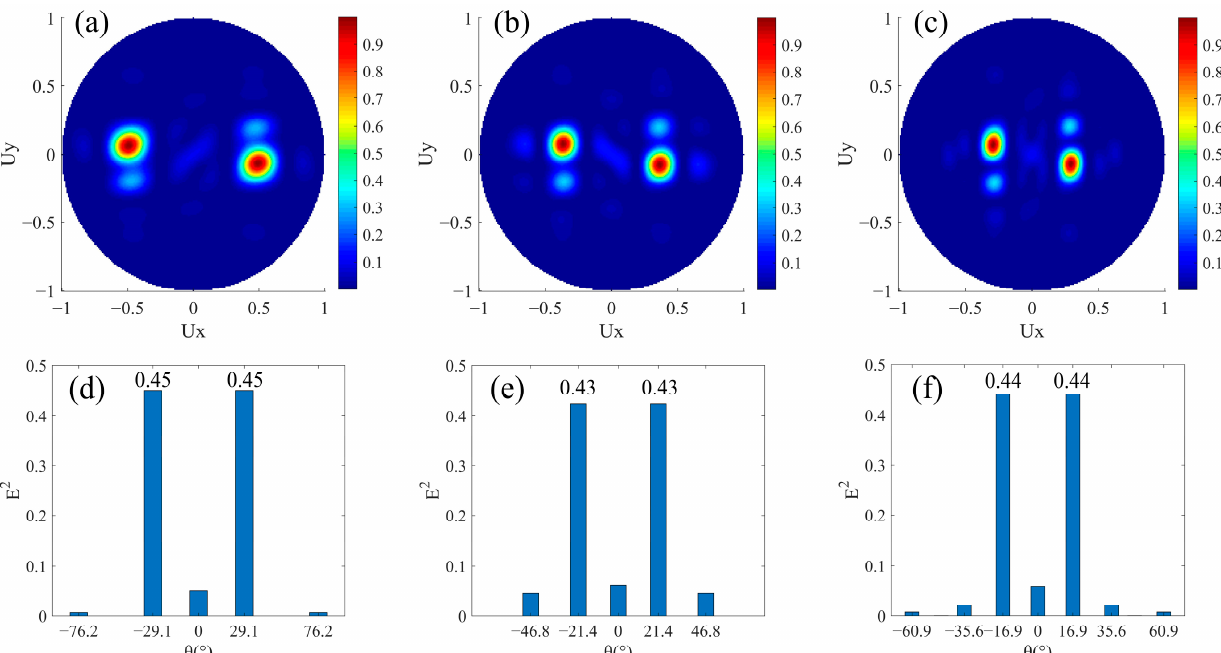
Figure 2. Simulation results of beam splitters with same split angle and energy. N l = N r , M = 0. The normalized far-field projection intensity distributions of designs ( a ) N l = N r = 3, ( b ) N l = N r = 4, and ( c ) N l = N r = 5, respectively. ( d – f ) are the normalized field intensity under the main split angle corresponding to the results of ( a – c ), respectively.